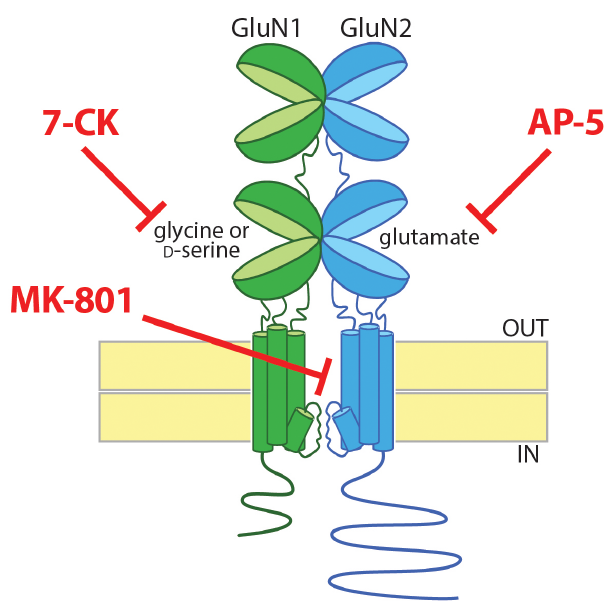
Figure 1. Pharmacology of the N-methyl- d -aspartate receptor (NMDAR). Most NMDARs are tetrameric proteins containing two GluN1 and two GluN2 subunits (for clarity, only one of each is pictured). For the NMDAR channel to open, both glutamate and a co-agonist, which can be glycine or d -serine, need to bind to clamshell-like ligand-binding domains on the GluN2 and GluN1 subunits, respectively. There are multiple approaches to block ion flow through the NMDAR channel: a competitive antagonist for the glutamate-binding site on the GluN2 subunits (e.g. AP-5), a competitive antagonist for the glycine/ d -serine binding site on the GluN1 subunits (e.g. 7-CK), or an uncompetitive blocker of the channel itself (e.g. MK-801). 7-CK, 7-chlorokynurenic acid; AP-5, (2R)-amino-5-phosphonovaleric acid; MK-801,